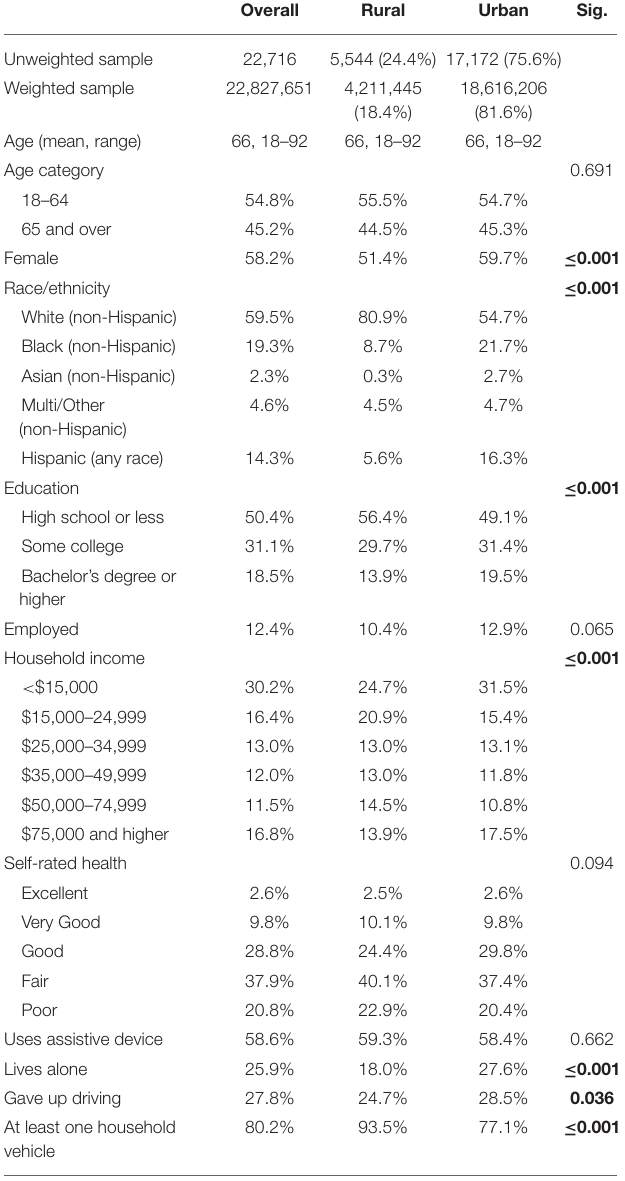
TABLE 1 | Weighted sample characteristics. Overall Rural Urban